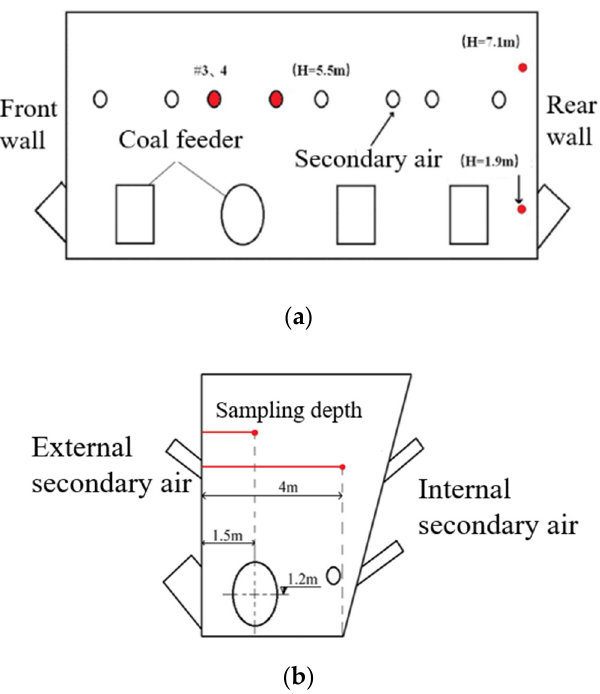
Figure 3. Test points of the secondary air system (a) front view and (b) side view. (#3 and #4 are sampling points of secondary air pipes)